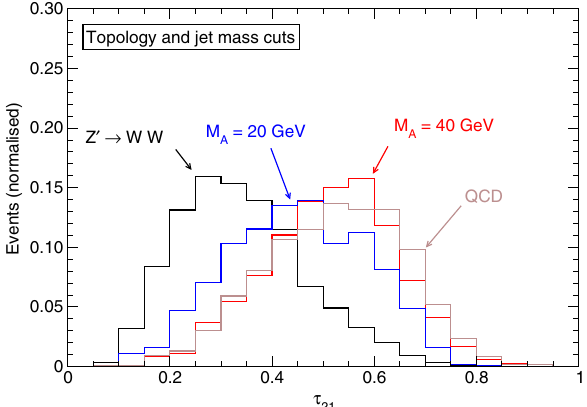
Fig. 20 N -subjettiness ratio τ 21 for heavier stealth boson signals S → Z A . For comparison, we show the distributions for the leading jet in Z (cid:8) → WW and the QCD dijet